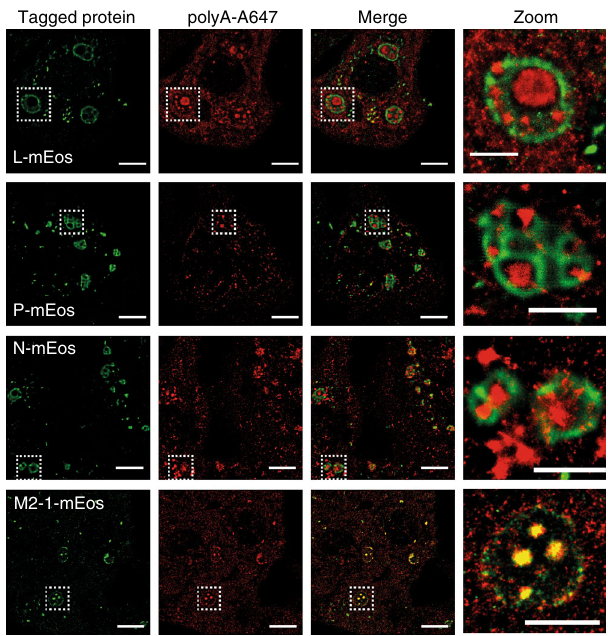
Fig. 5 Dual color single-molecule localization microscopy of the viral proteins and mRNA inside IBs. BSRT7/5 cells were transfected with plasmids encoding the N, P, L and M2-1 proteins and the M/Luc subgenomic minireplicon. The mEos tagged protein was expressed instead of the corresponding wild-type protein as indicated on the picture. FISH analyses detecting poly(A)-mRNA were performed in order to visualize IBAGs. PALM-STORM images were realized as indicated in Methods section. The fi rst column from the left shows a PALM image of the viral protein labeled with mEos ( green ). The second column shows a STORM image of the poly(A)-mRNA ( red ). The third column shows a superposition of the images from the fi rst and second columns. Representative images from two independent experiments are shown, scale bar 5 µ m. The boxed areas enclose IBs that are shown magni fi ed in the fourth column, scale bar 2 µ